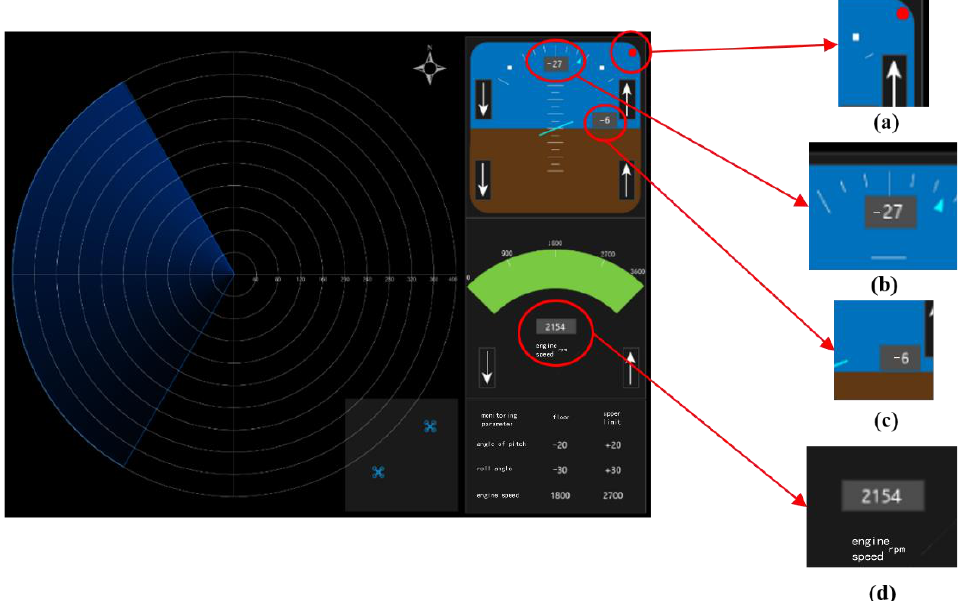
Figure 1. Simulated flight-parameter-monitoring interface: ( a ) prompt to adjust the pitch angle alarm; ( b ) pitch angle parameter; ( c ) roll angle parameter; and ( d ) engine speed parameter.